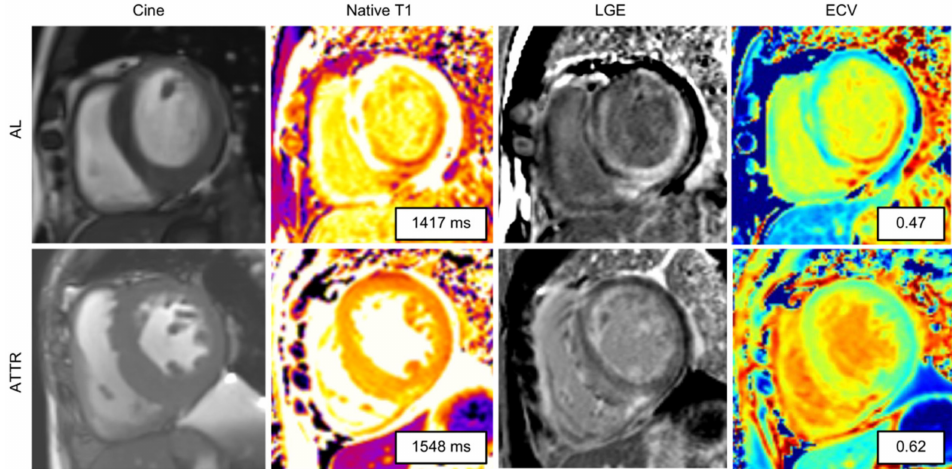
Figure 3. Cardiac magnetic resonance (CMR) findings of cardiac amyloidosis. Figure 3 shows end- diastolic cine stills, native T1 maps, late gadolinium enhancement (LGE) images, and extracellular volume (ECV) maps in patients with AL (top row) and ATTR (bottom row) CA. Note the thickened ventricular wall in cine imaging. In cardiac amyloidosis, native T1 and ECV were elevated. LGE imaging demonstrated diffuse subendocardial to transmural